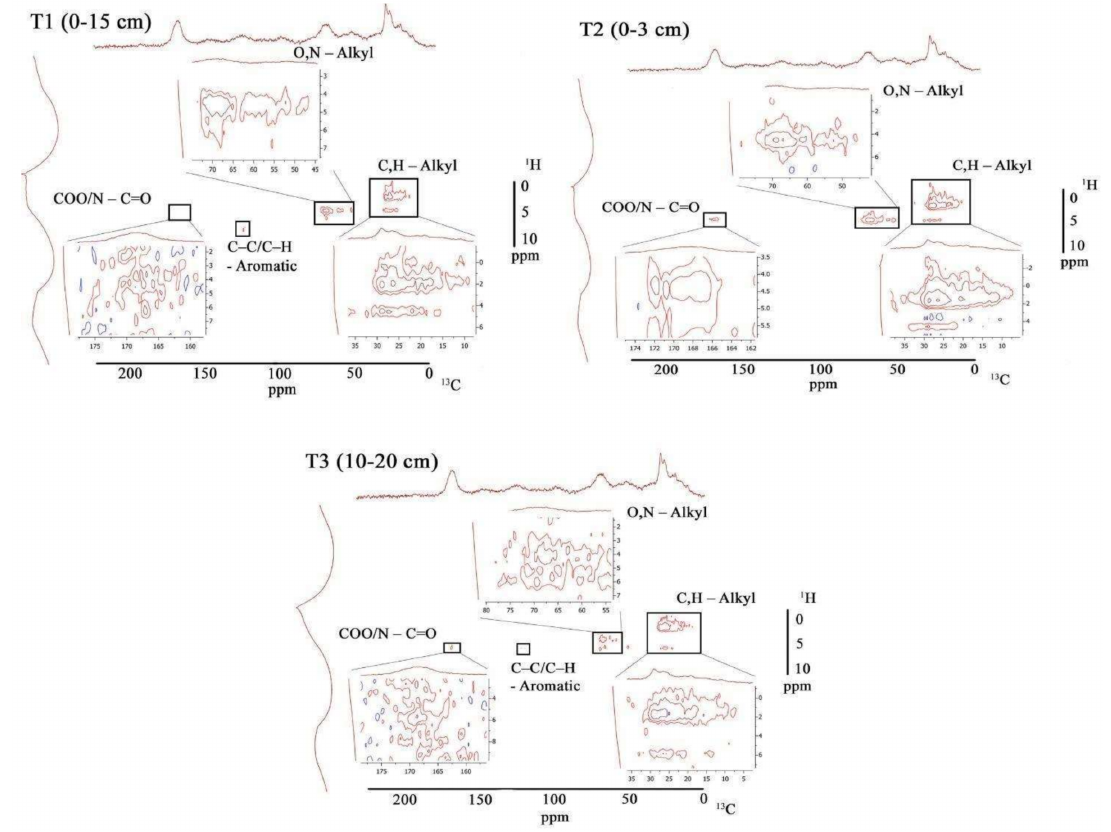
Figure 5. The 1 H- 13 C HETCOR NMR spectra of studied soils. Time of relaxation is 750 µ